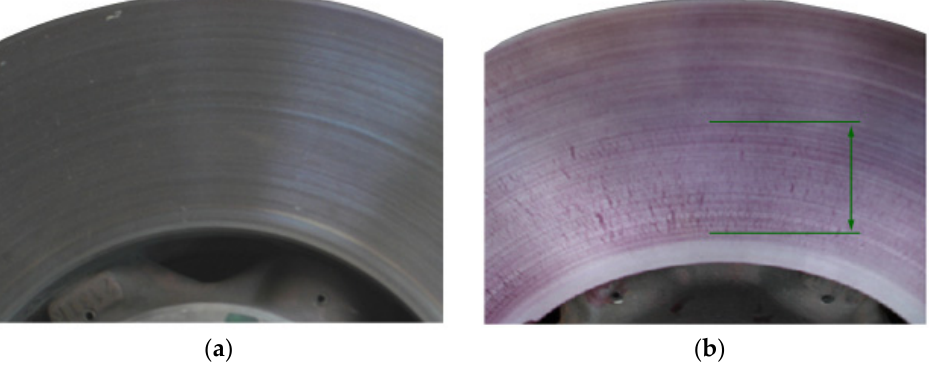
Figure 5. Condition of the friction surface of the T1 (Nodular Cast Iron) disc after the first braking: ( a ) before penetration testing and ( b ) after penetration testing (place of cracks marked green).